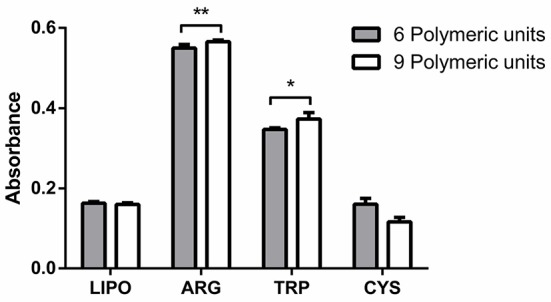
Absorbance at 480 nm corresponding to six polymerized units conjugated effectively (gray bars) and absorbance at 520 nm corresponding to nine polymerized units conjugated effectively (white bars). LIPO, lipopolymer alone; ARG, TRP, CYS, lipopolymer containing l-arginine, l-tryptophan, and l-cysteine, respectively. Data are presented as mean ± SD of four independent experiments. *Significant differences respect to lipopolymer without aminoacids (P < 0.05). **Significant differences with respect to lipopolymer without aminoacids (P < 0.01).